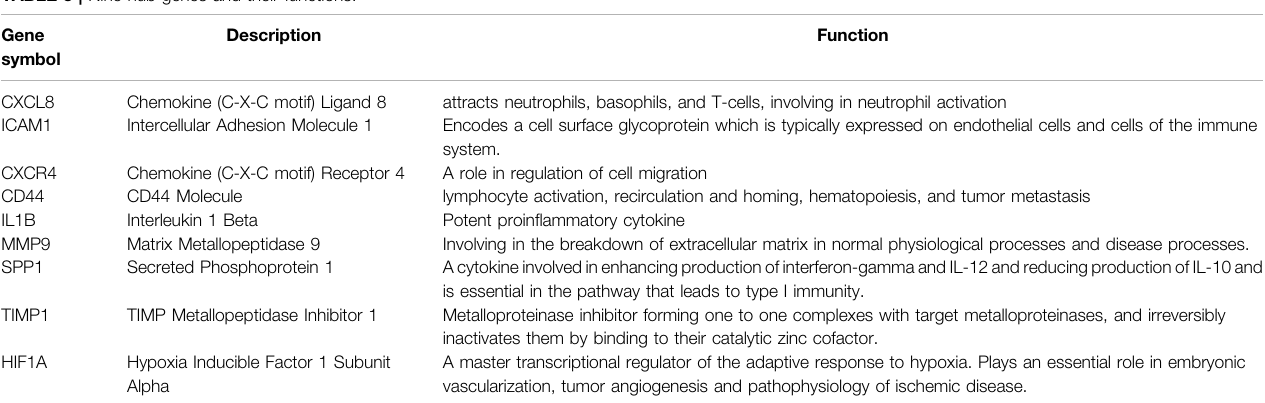
TABLE 3 | Nine hub genes and their